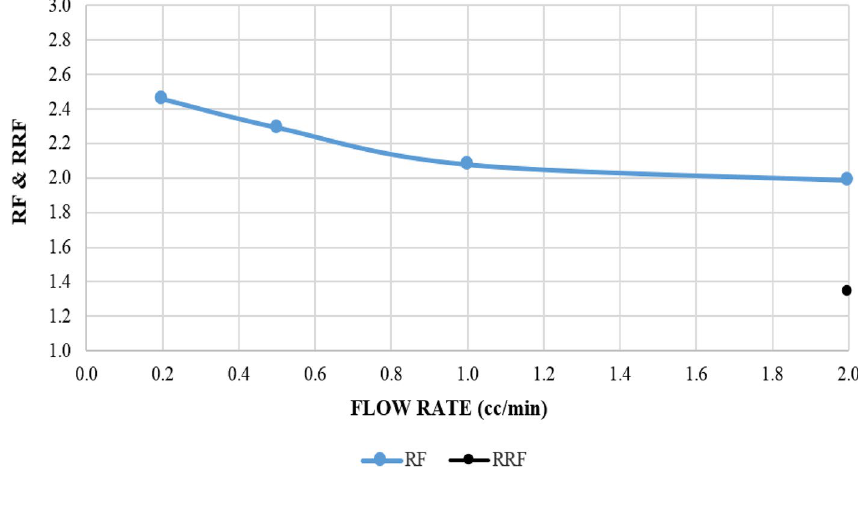
Fig. 10 ISSM profile across the core length showing the changes in water saturation during oil recovery of Exp.